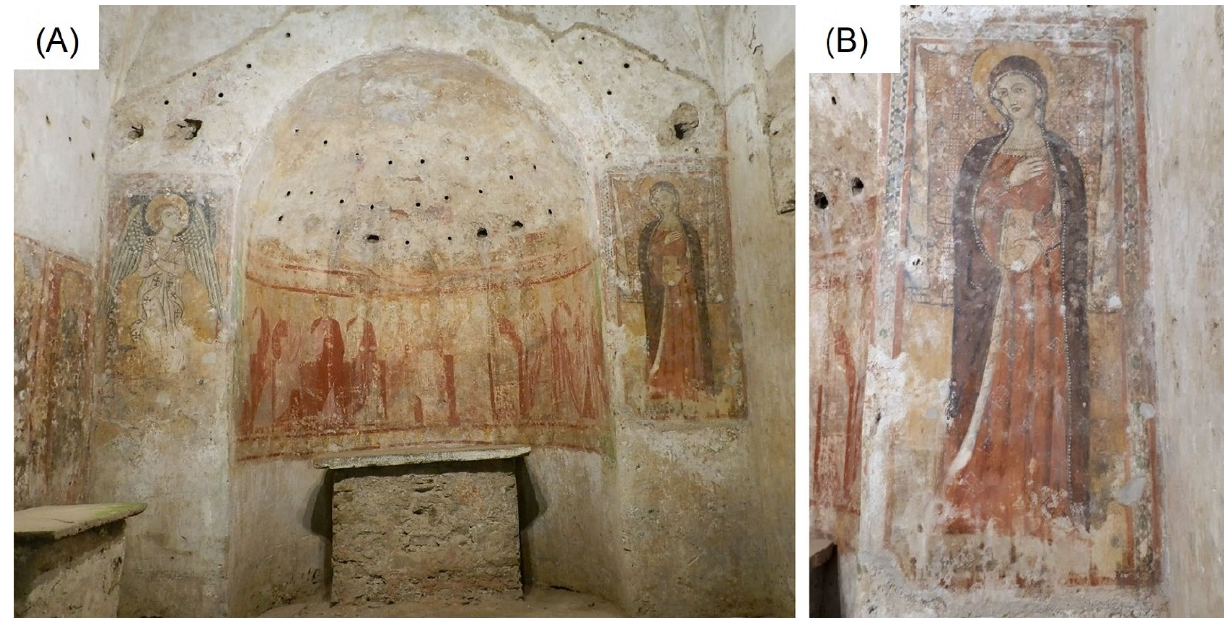
Figure 1. ( A ) Overview of the cycle of frescoes in the church of Sotterra with evidence, from left to right, of the angel of the Annunciation, Christ in glory with apostles and the Virgin. ( B ) Detail of the Virgin as part of the mural painting object of this study.